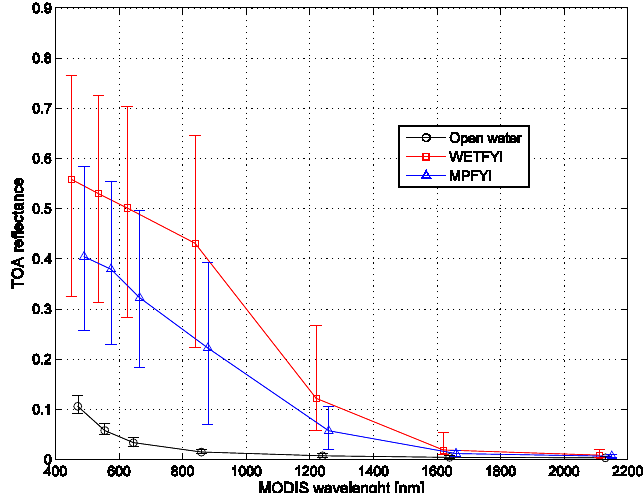
Figure 4. The MODIS TOA reflectance spectra for open water, sea ice covered with wet snow or early stage melt ponds (WETFYI) and melt ponded ice (MPFYI) under summer conditions in the Kara Sea in June–July 2009. The vertical lines show 90% variation interval of the measured TOA reflectances. The MODIS bands from left to right are 3, 4, 1, 2, 5, 6, and 7.